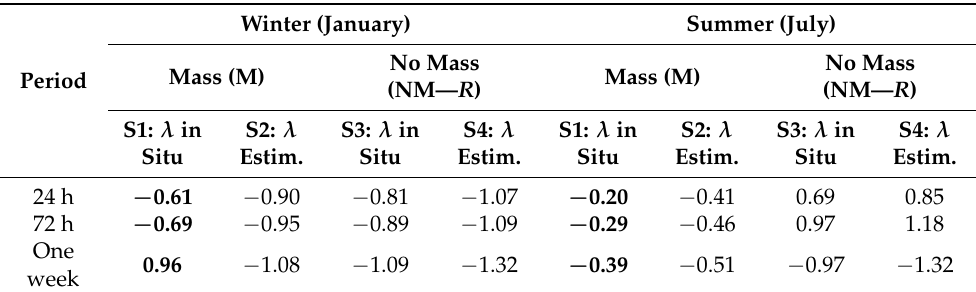
Table 8. Maximum temperature deviation between in situ air temperature measurements and simulations in ◦ C 1 . In bold: simulated values that are closer to the measured